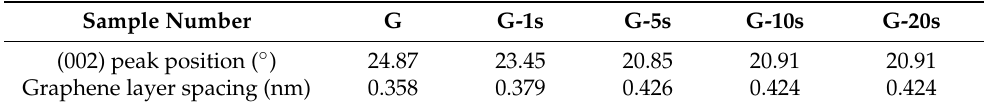
Table 3. X-ray diffraction pattern of modified graphene sample (002) peak position and interlayer spacing.